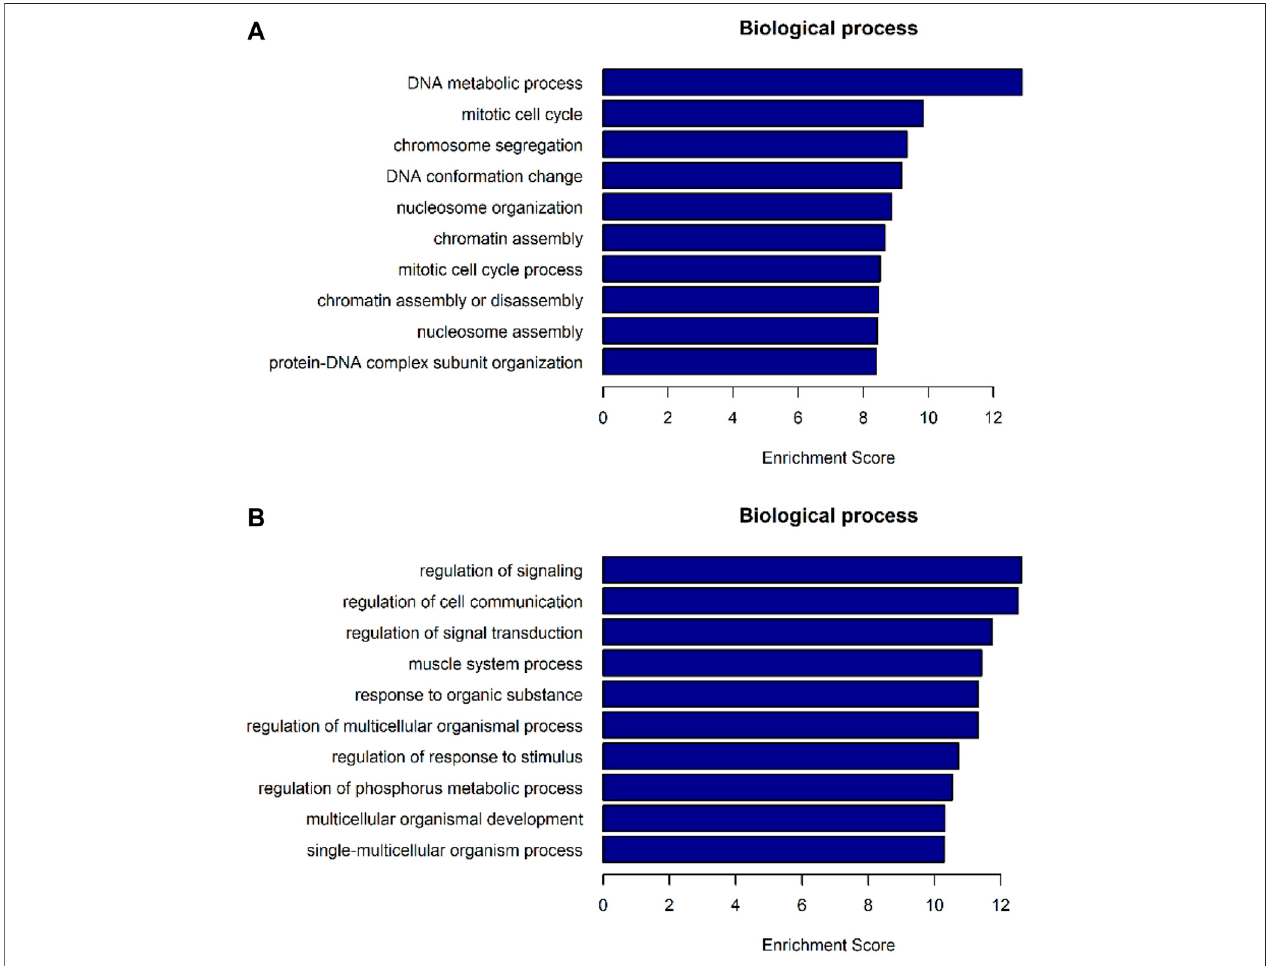
FIGURE7| GO-enrichmentanalysisfordifferentiallyexpressedmRNAs. (A) Top10biologicalprocessesofmRNAenrichmentup-regulatedbydifferences. (B) Top 10 biological processes of mRNA enrichment were differentially down-regulated.